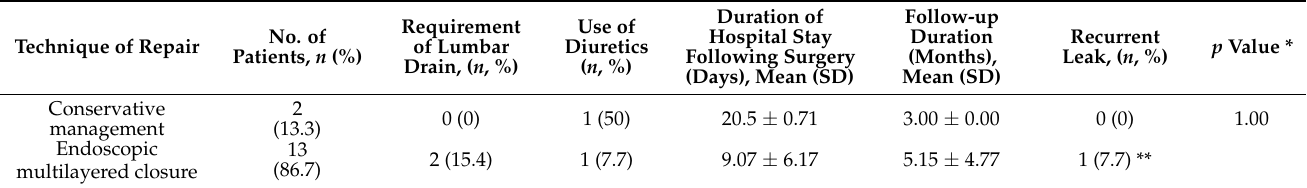
Table 5. Comparison of outcomes between conservative and endoscopic